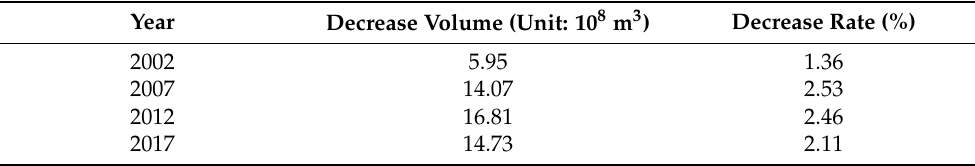
Table 1. Wastewater reduction effects to the entire economic system by reducing 10% final demand on sectors in